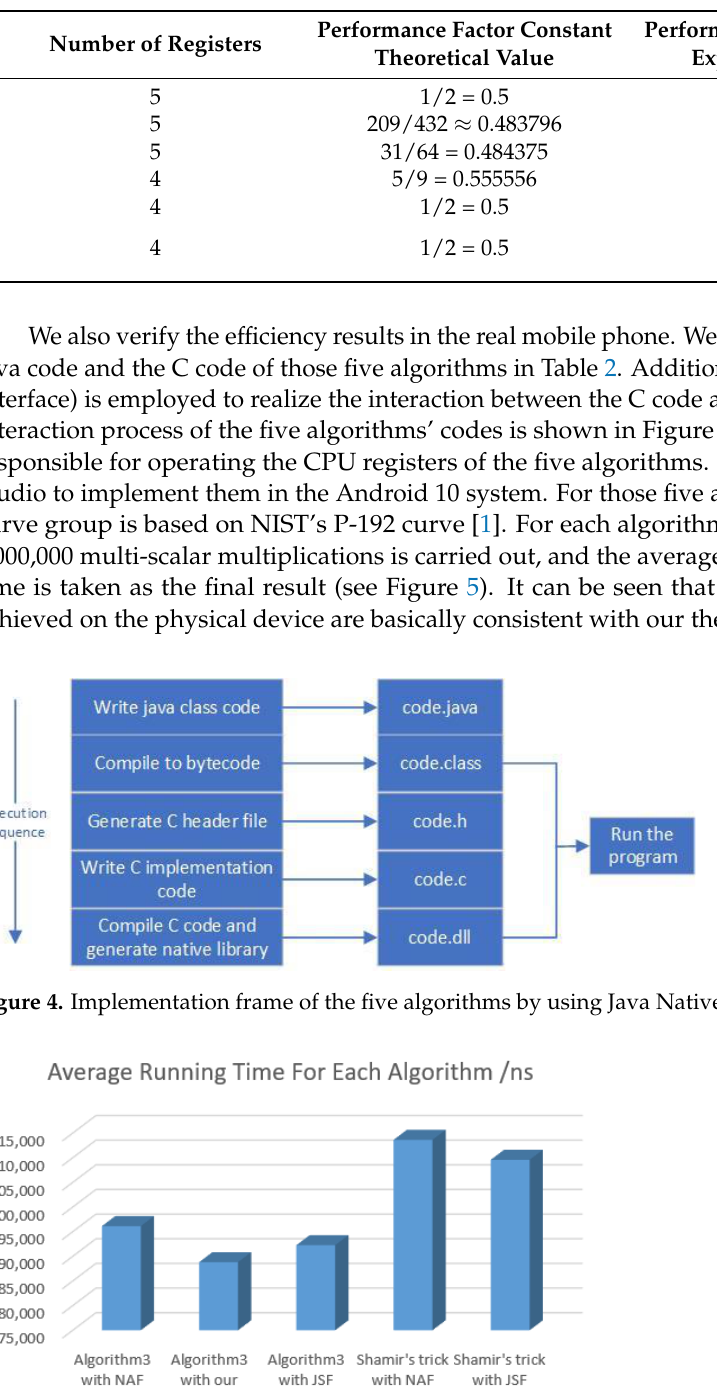
Table 2. Comparison with the related methods.